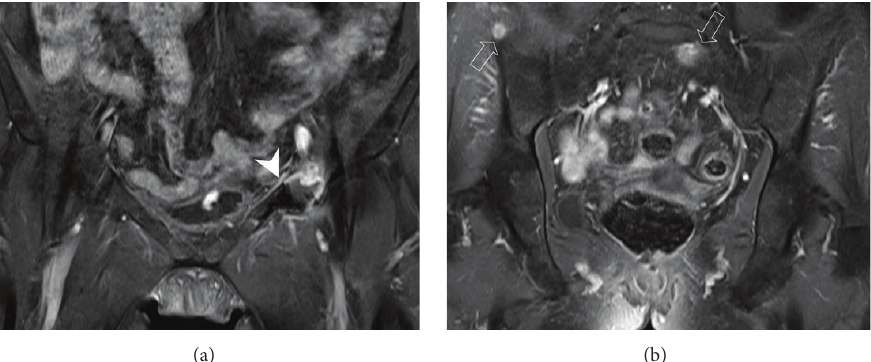
Figure 3: Coronal contrast-enhanced fat-saturated T1W images obtained two months after the procedure demonstrate complete tumor necrosis with thin peripheral rim enhancement of the ablation zone (arrowhead) but progression of the metastatic disease with two new pelvic lesions (open